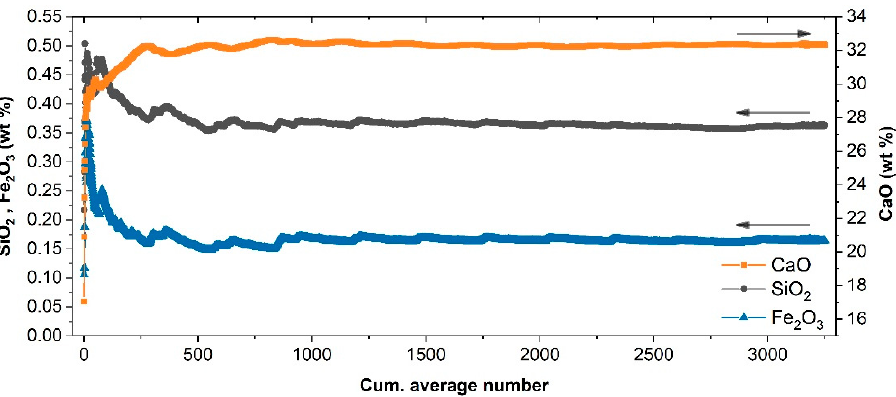
Figure 8. Estimated concentration applying the calibration model to the cumulative averaged spectrum of the 2D scan of Figure 7 on sample S 33 . spectrum of the 2D scan of Figure 7 on sample S 33